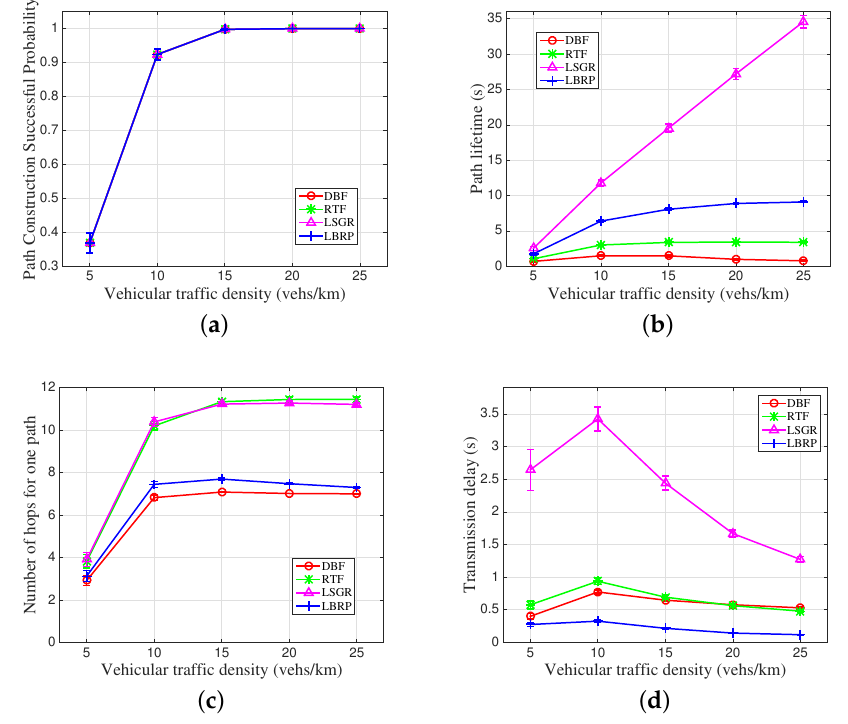
Figure 5. The influence of vehicular traffic density on four different routing metrics. ( a ) Path construction successful probability; ( b ) One path lifetime; ( c ) Number of hops; ( d ) Transmission delay. DBF, Distance-Based Forwarding; RTF, Random Timer Forwarding; LSGR, Link State-aware Geographic